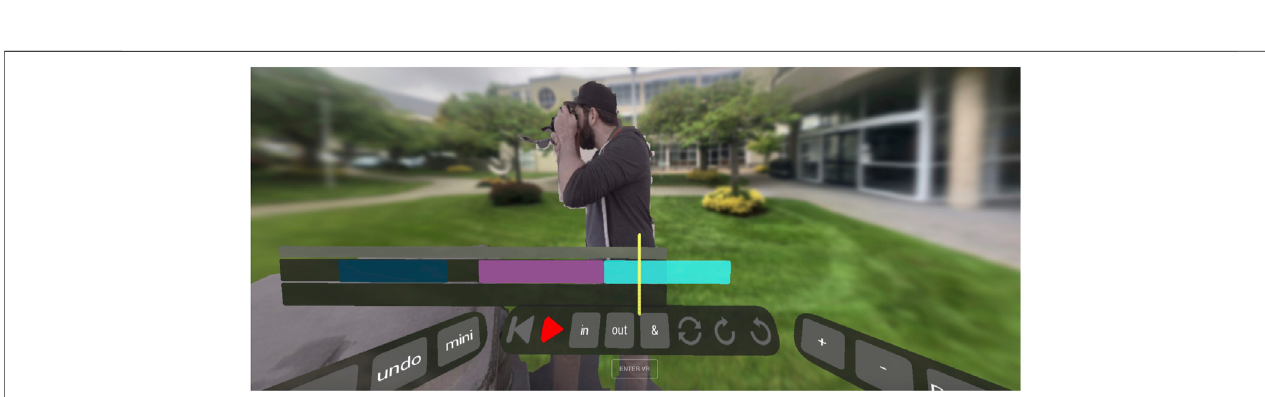
FIGURE 6 | Spatial Editing: Combining two 6DoF videos. One video shows a person with a camera, the other video clip displays a courtyard. The fi rst video clip is combined with the second video clip using a two-track timeline. Please note that the artifacts visible around the person are due to depth map inaccuracies and not a problem speci fi c to the immersive video editor.